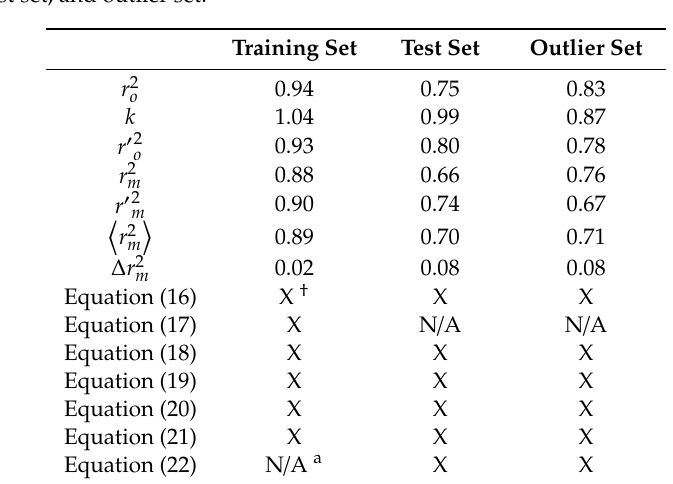
Table 5. Validation verification of HSVR based on prediction performance of the molecules in the training set, test set, and outlier